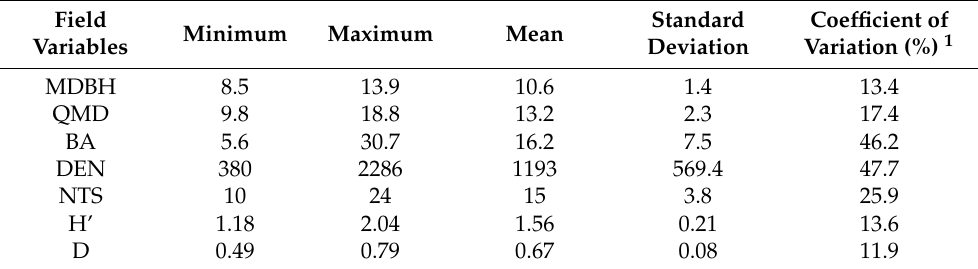
Table 1. Statistics about forest variables calculated from field data.